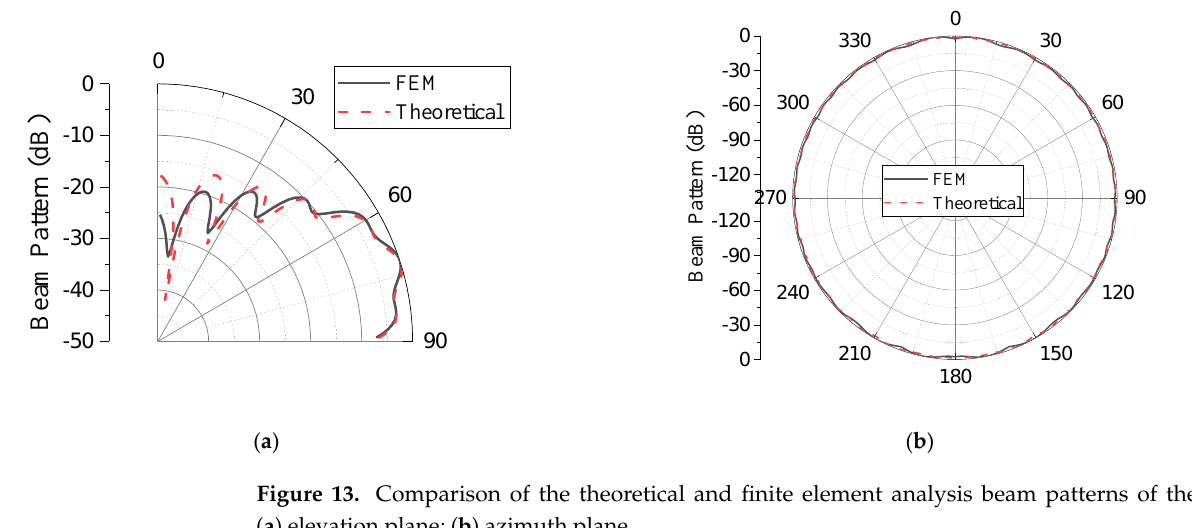
Figure 12. Finite element models of the SA: ( a ) aluminum base platform; and ( b ) array covered with a water layer.